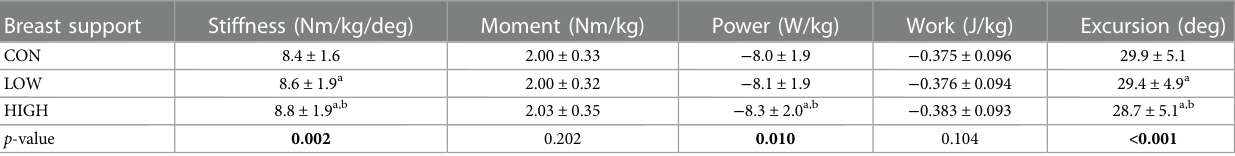
TABLE 3 Mean kinematic and kinetic variables during the treadmill running task. Breast